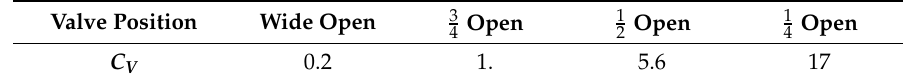
Table 3. Values for the head loss coe ffi cient C V depending on the opening of a flap gate valve according to